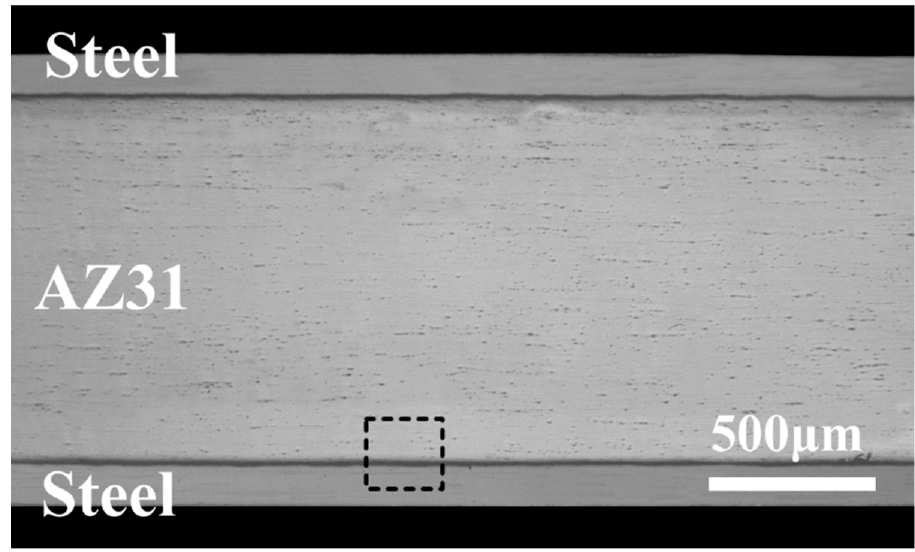
Figure 2. Cross-section of the multilayer sheet.